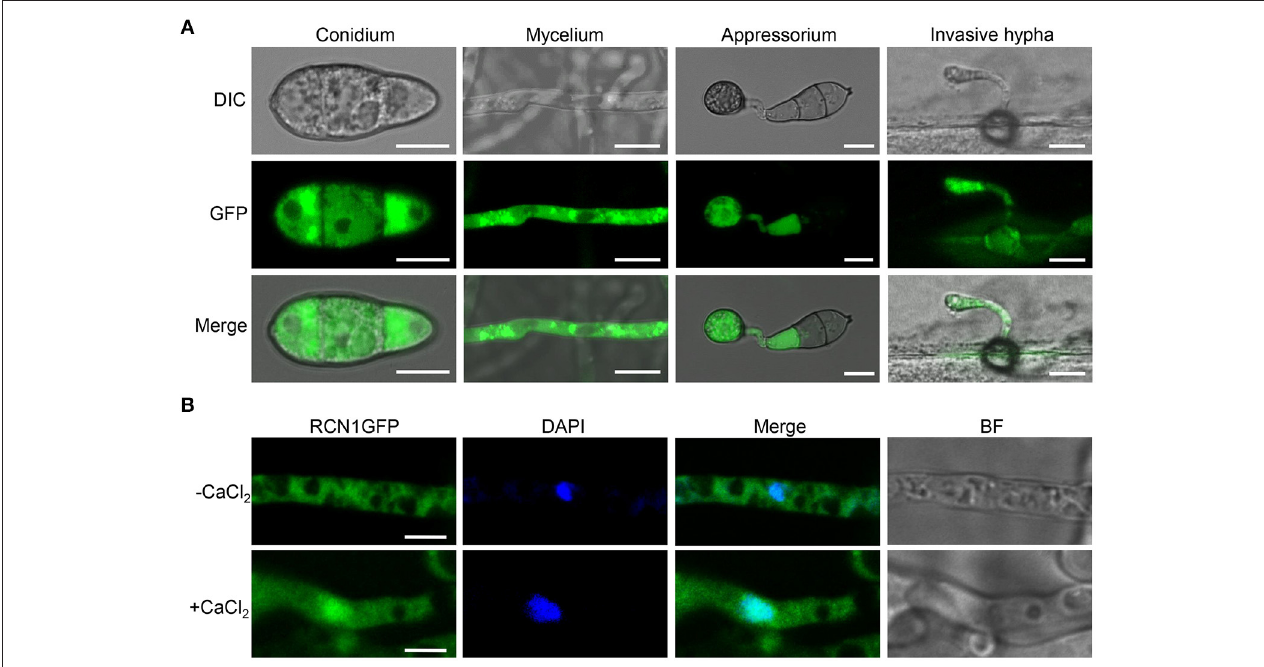
FIGURE 6 | Subcellular localization of MoRCN1 at different developmental stages of M. oryzae . (A) Subcellular localization of GFP-Rcn1 in conidia (CO), mycelium (MY), appressoria (AP), and primary invasive hyphae (PH). Bar 10 µ m. (B) Subcellular localization of GFP-Rcn1 in mycelium with and without CaCl 2 (200mM) induction. Nuclei were visualized by using the fluorescent dye DAPI. Bar 10 µ